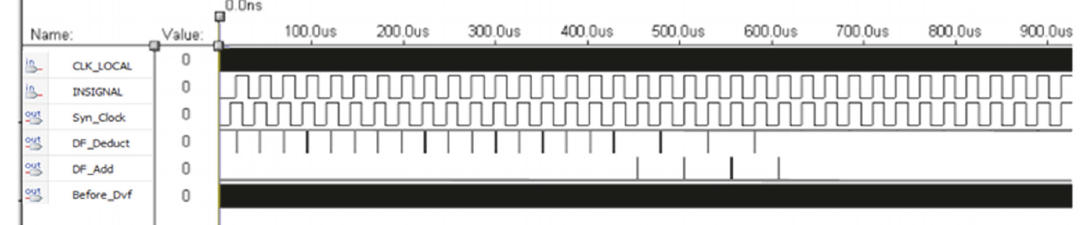
Figure 14: System simulated results with adding digital filter. CLK LOCAL: the local clock, INSIGNAL: the input signal, Syn Clock: the synchronizationclock,DF Deduct:theleadingcontrolpulseofdigitalfiltermodule,DF Add:thelaggingcontrolpulseofdigitalfiltermodule, Before Dvf: control module output/frequency divider